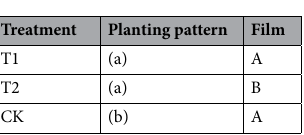
Table 3. Treatment of